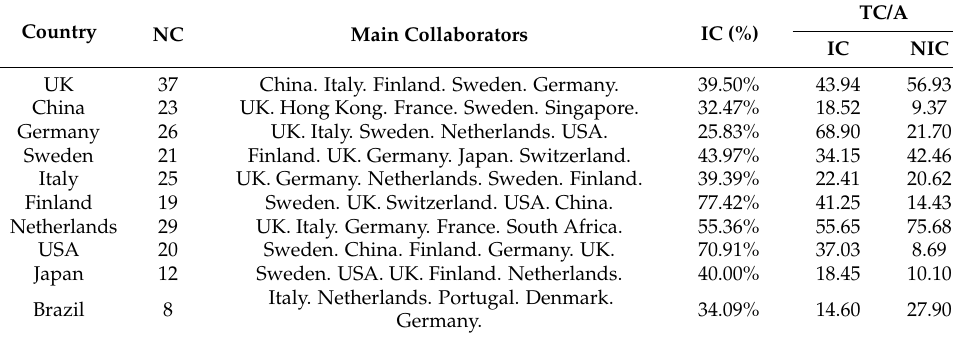
Table 6. International collaboration of the most prolific countries.